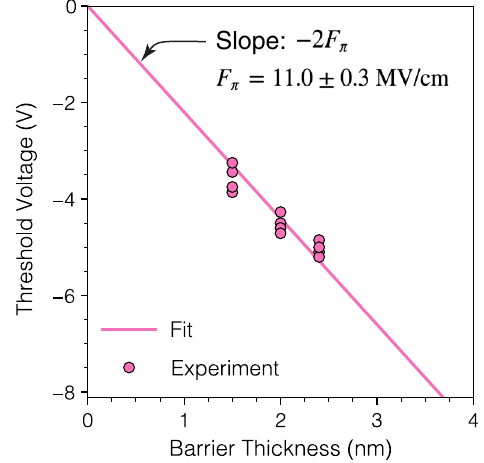
FIG. 6. Critical threshold voltage V as a function of barrier th thickness for a set of RTDs exhibiting NDC at room temperature. Several devices were measured on each of the fabricated